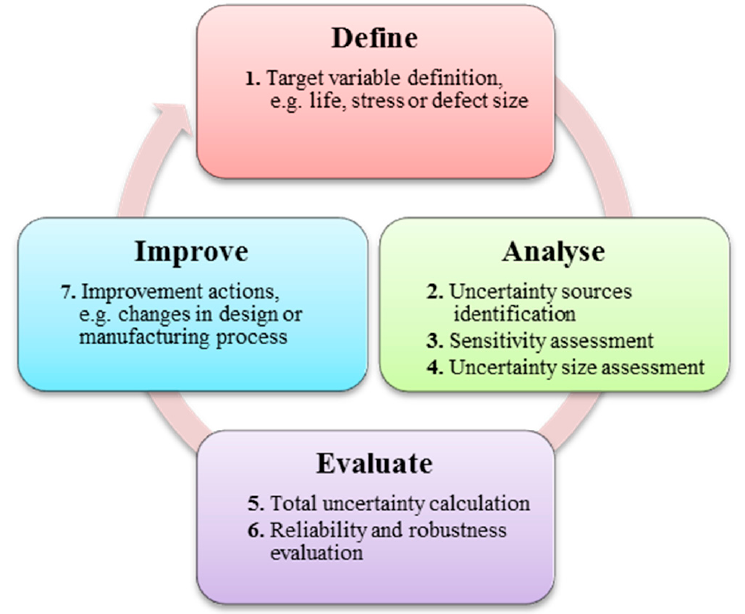
Figure 5. VMEA in the design and improvement cycle.